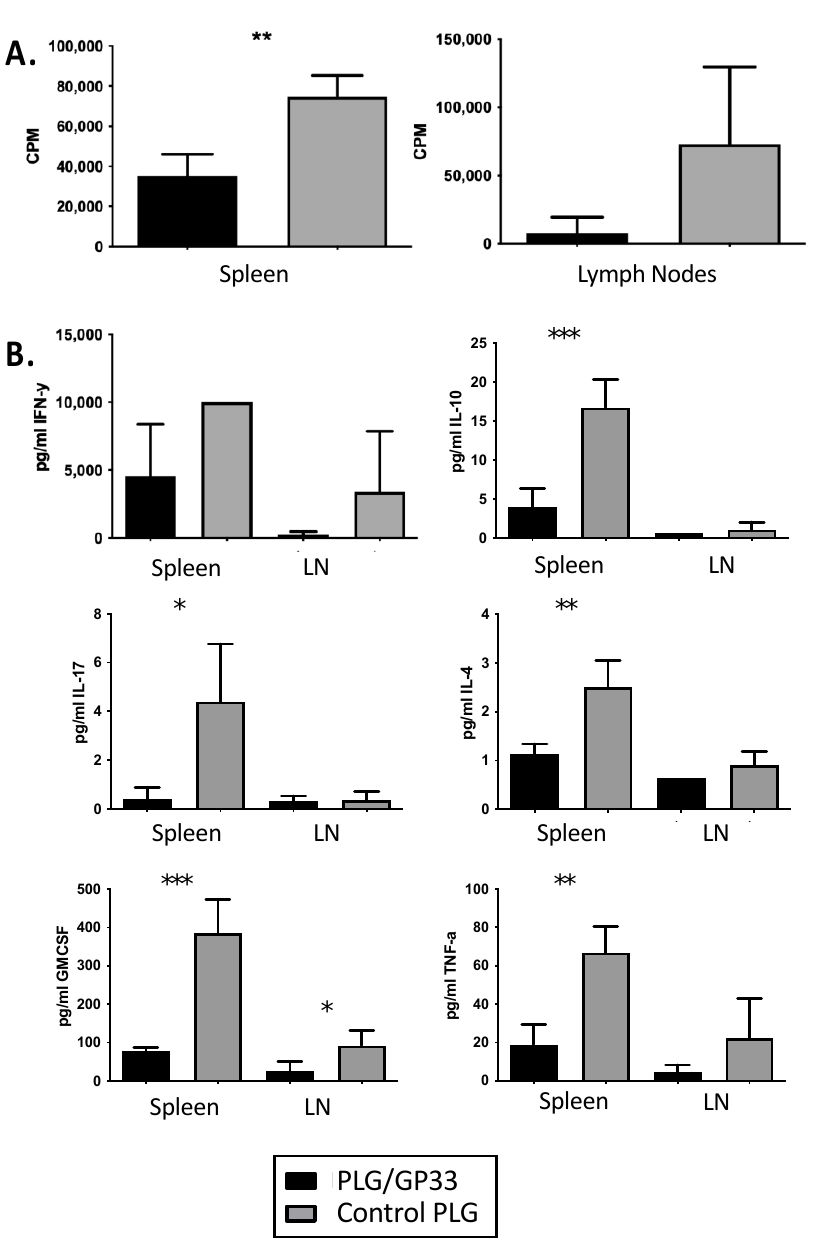
Figure 3. Recall culture of PLG/GP33-treated splenocytes. Female P14 mice ( n = 3–4) were injected intravenously with either PLG/GP33 or a control PLG (PLG/OVA323 or PLG). Spleens, as well as axillary, brachial, and inguinal lymph nodes, were harvested 3 days later. Cells (2 × 10 5 per well) were cultured in vitro with GP33 peptide for 3 days. ( A ) Proliferation was determined by [ 3 H]TdR incorporation. ( B ) Cytokine levels were determined by a cytometric bead array.